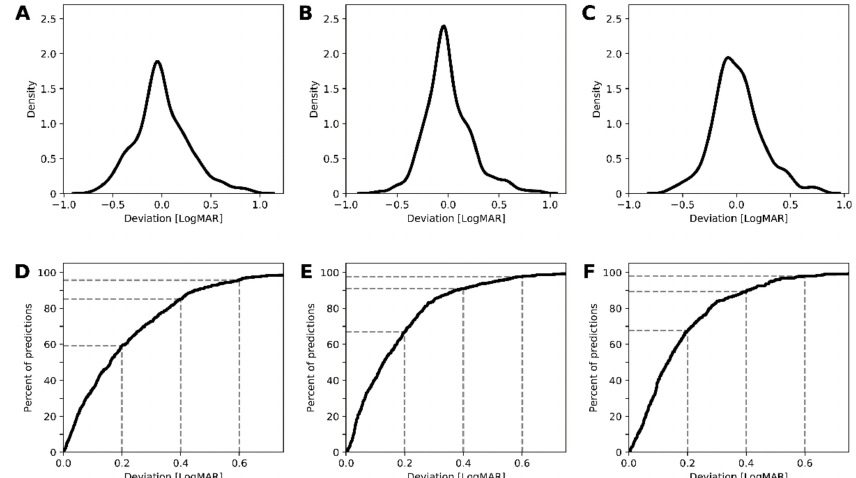
Figure 5. Model performance for the prediction of best corrected visual acuity (BCVA). The density plots that demonstrate the deviation of the predictions from the measured BCVA values (top row, A–C ), and graphs that plot the cumulative true positive rate against the deviation (bottom row, D–F ), are demonstrated for the models based on feature set A (first column, A and D ), B (second column, B and E ), and C (third column, C and F ). The inclusion of foveal status with (feature set C , third column) or without (feature set B , second column) demographic data improved the performance of the ensemble machine learning algorithms compared to pure retinal thickness data (feature set A , first column).